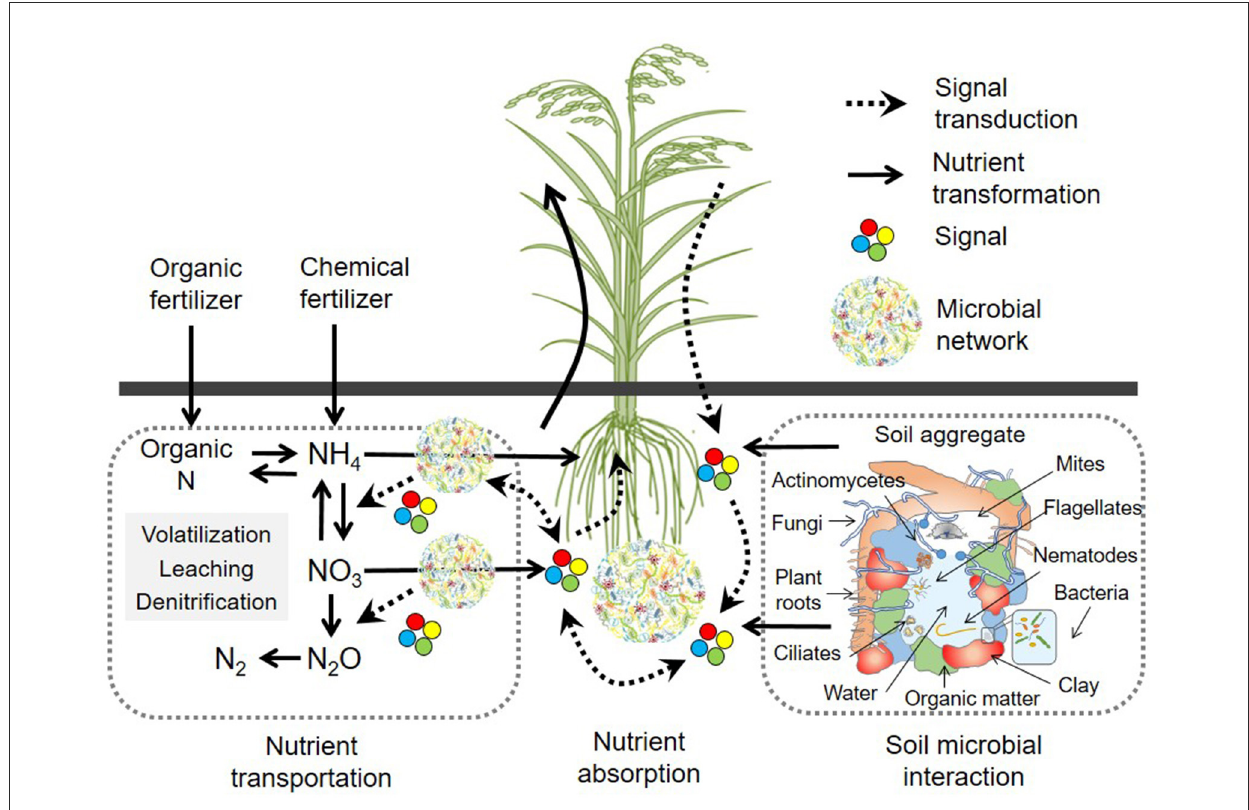
FIGURE1 The impact of biotic interactions on soil nutrient transformation in agricultural